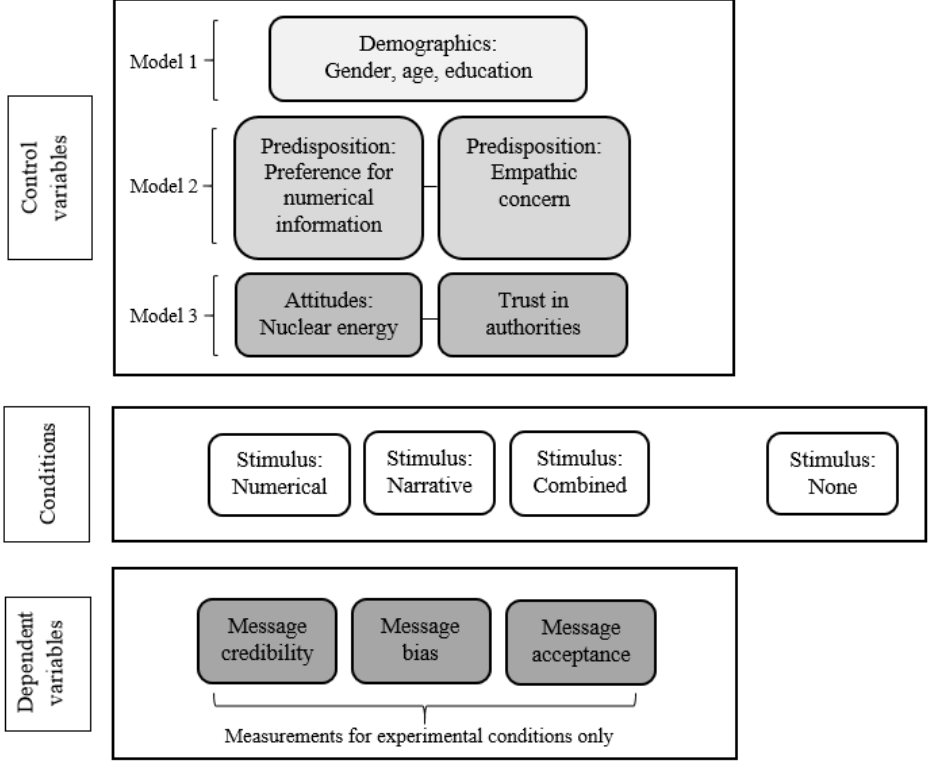
Figure A2. Experiment design.